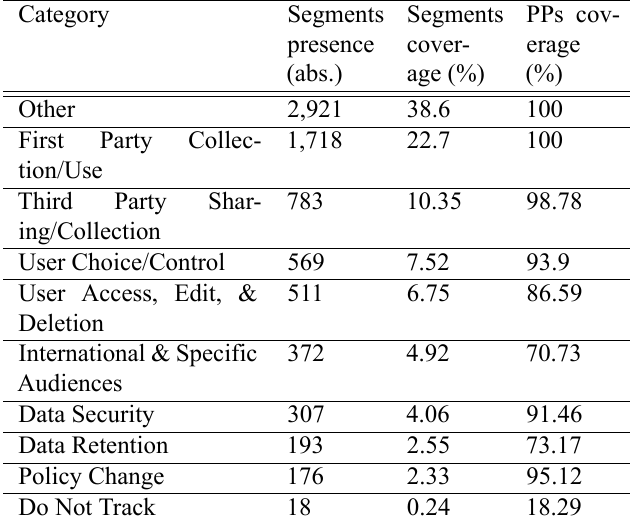
Table3. By-category description for the data practices in the